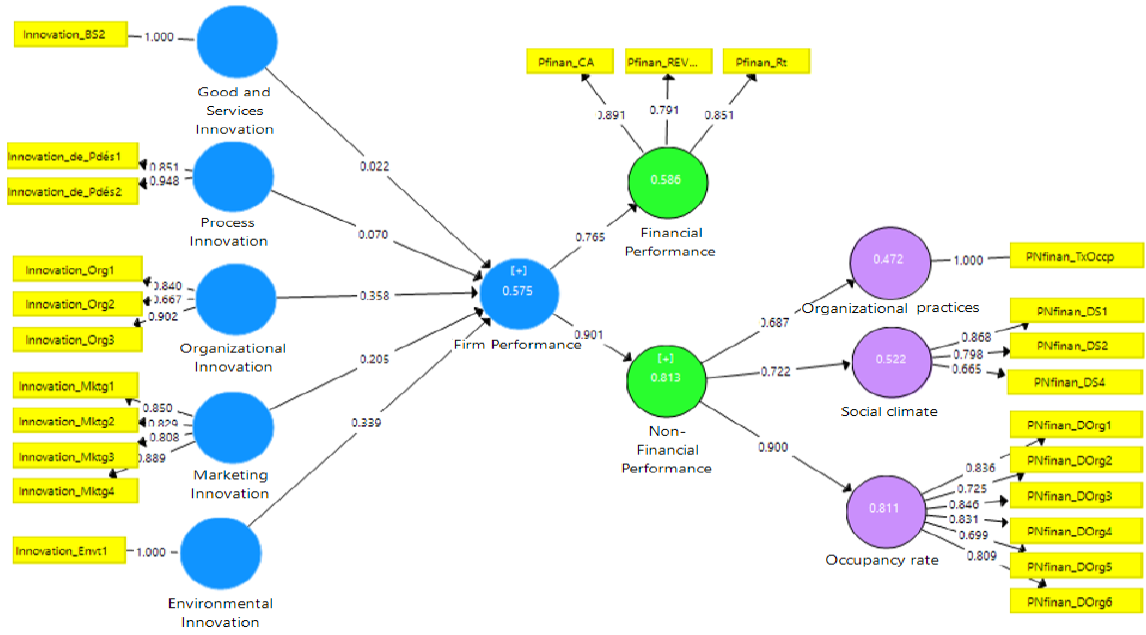
Figure 2: The adjusted structural model (using Smart PLS 3 Software)